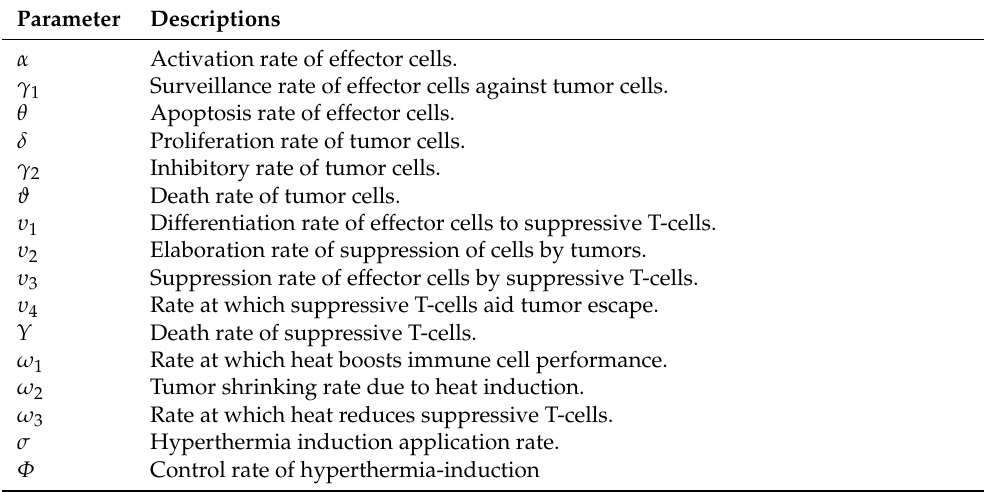
Table 1. System (1) Parameter